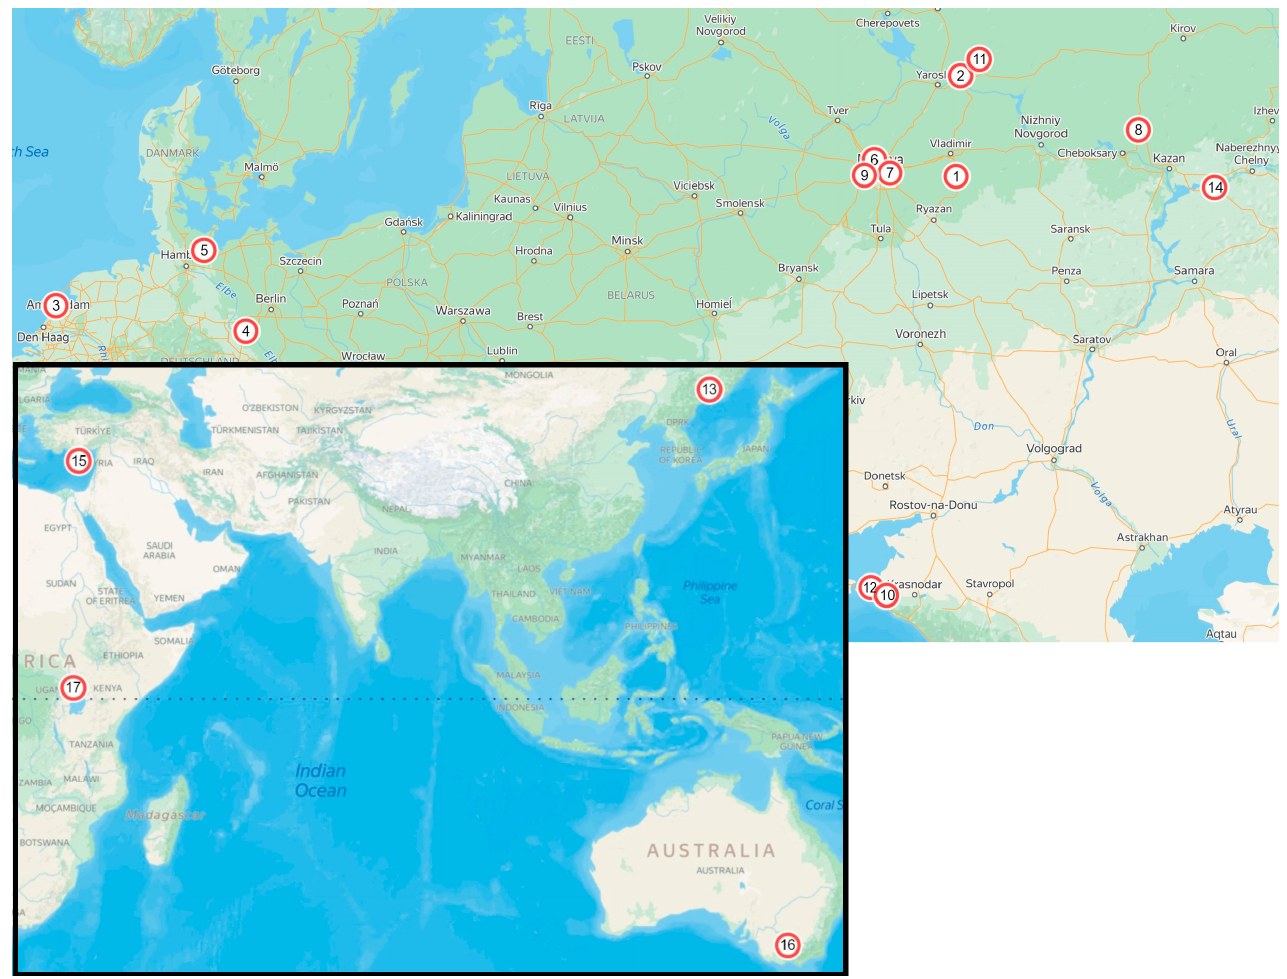
Figure 1. Location of collection sites (see also Table 1). Russia: 1—Vladimir Region; 2, 11—Kostroma Region; 6, 7, 9—Moscow Region; 8—the Mari El Republic; 10, 12—Krasnodar Krai; 13—Primorsky Krai; 14—the Republic of Tatarstan; 3—the Netherlands; 4, 5—Germany; 15—the Republic of Cyprus; 16—Australia; 17—Uganda. Table 1. Details of isolates used in the study.